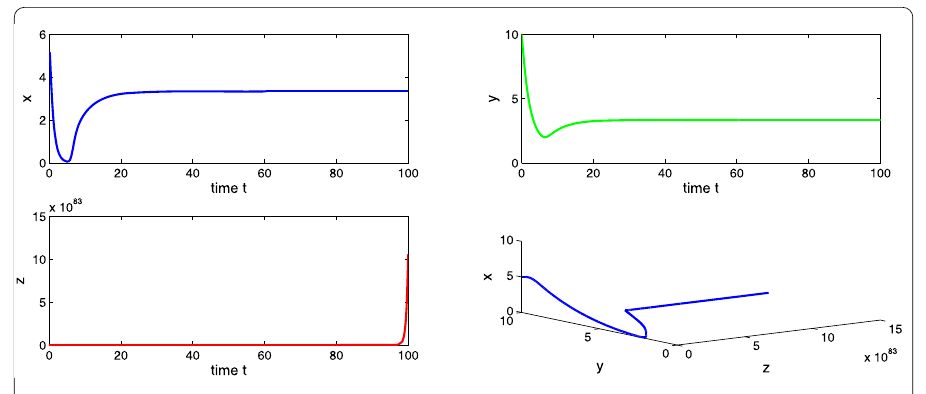
Figure 14 Time evaluation curve and three-dimensional phase portrait of the system for the parameter values a